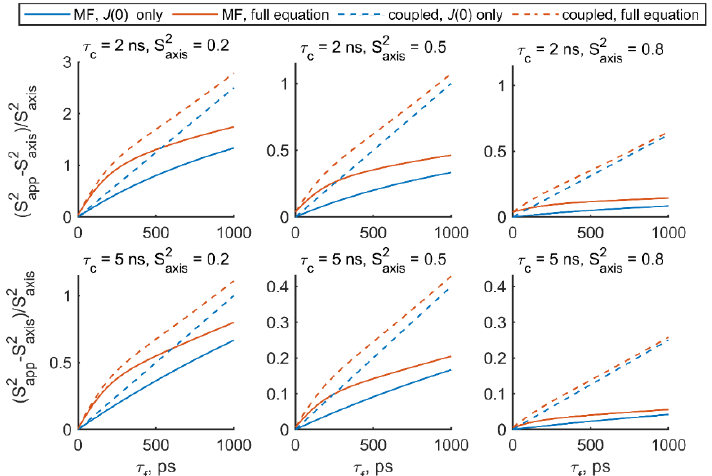
(cid:16) (cid:17) S 2 app − S 2 / S 2 , calculated with the spectral axis axis and the macromolecular limit axis